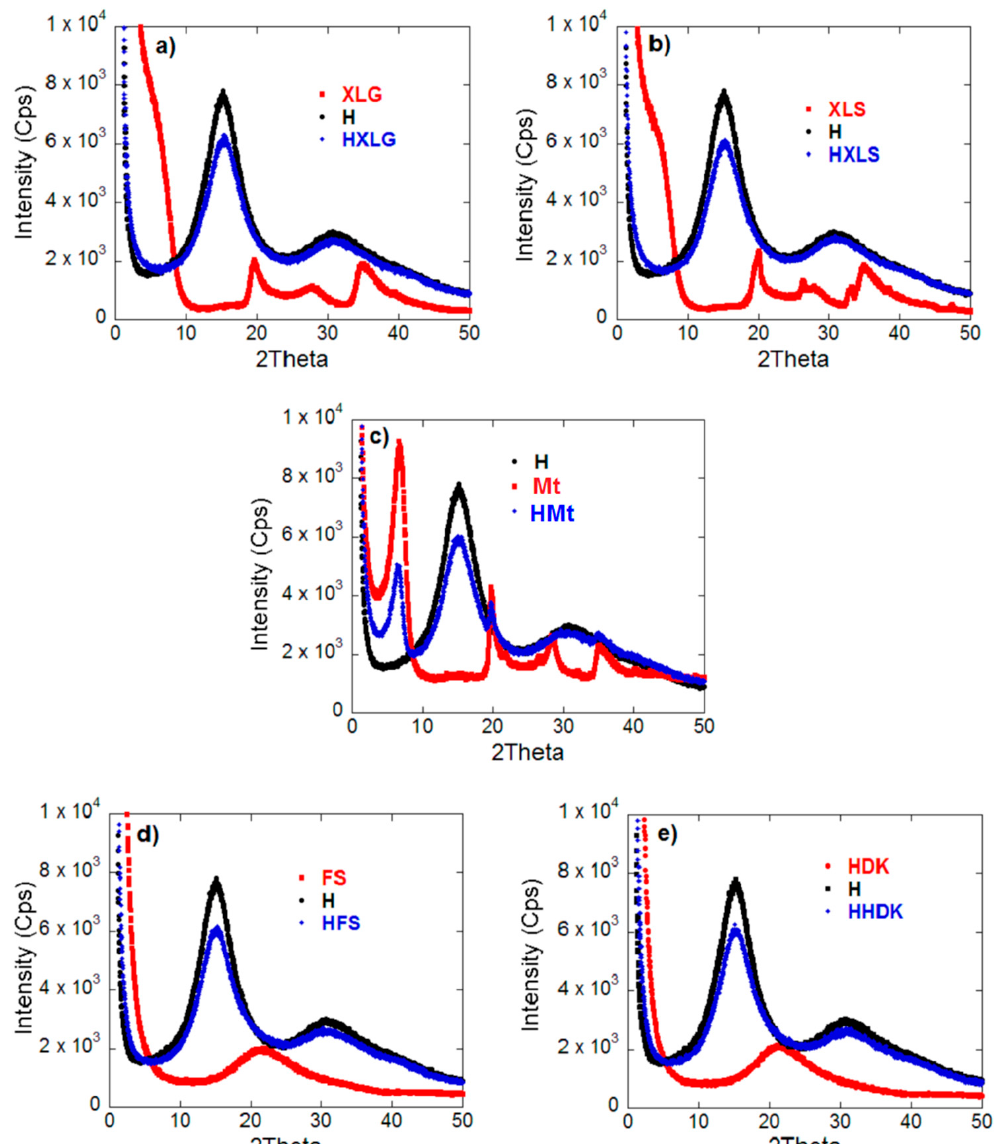
Figure 2. XRD spectra of both hydrogels investigated and reinforcing agents used. ( a ) HXLG; ( b ) HXLS; ( c ) HMt; ( d ) HFS; ( e ) HHDK.